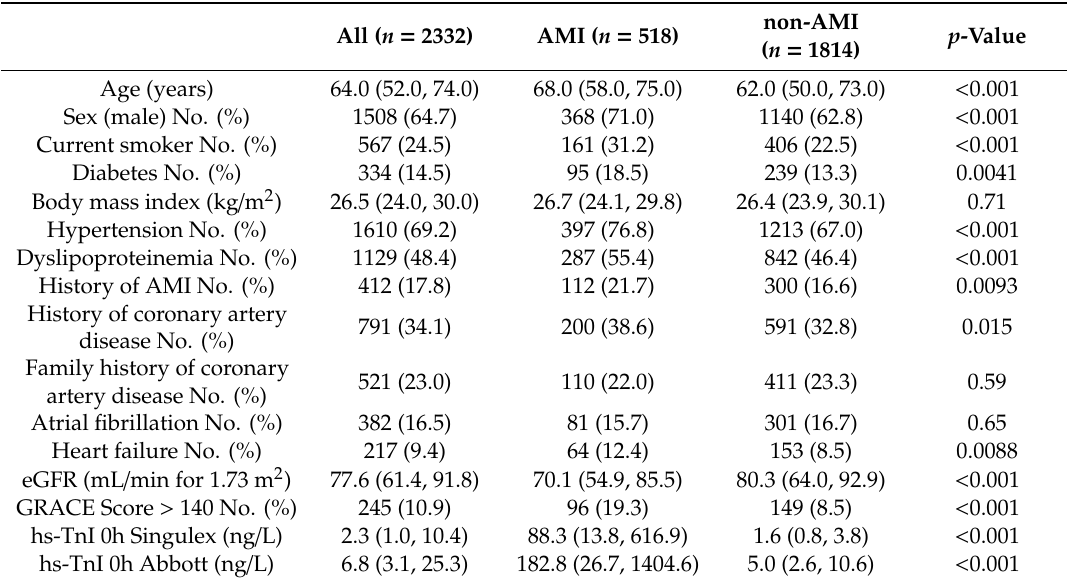
Table 1. Baseline